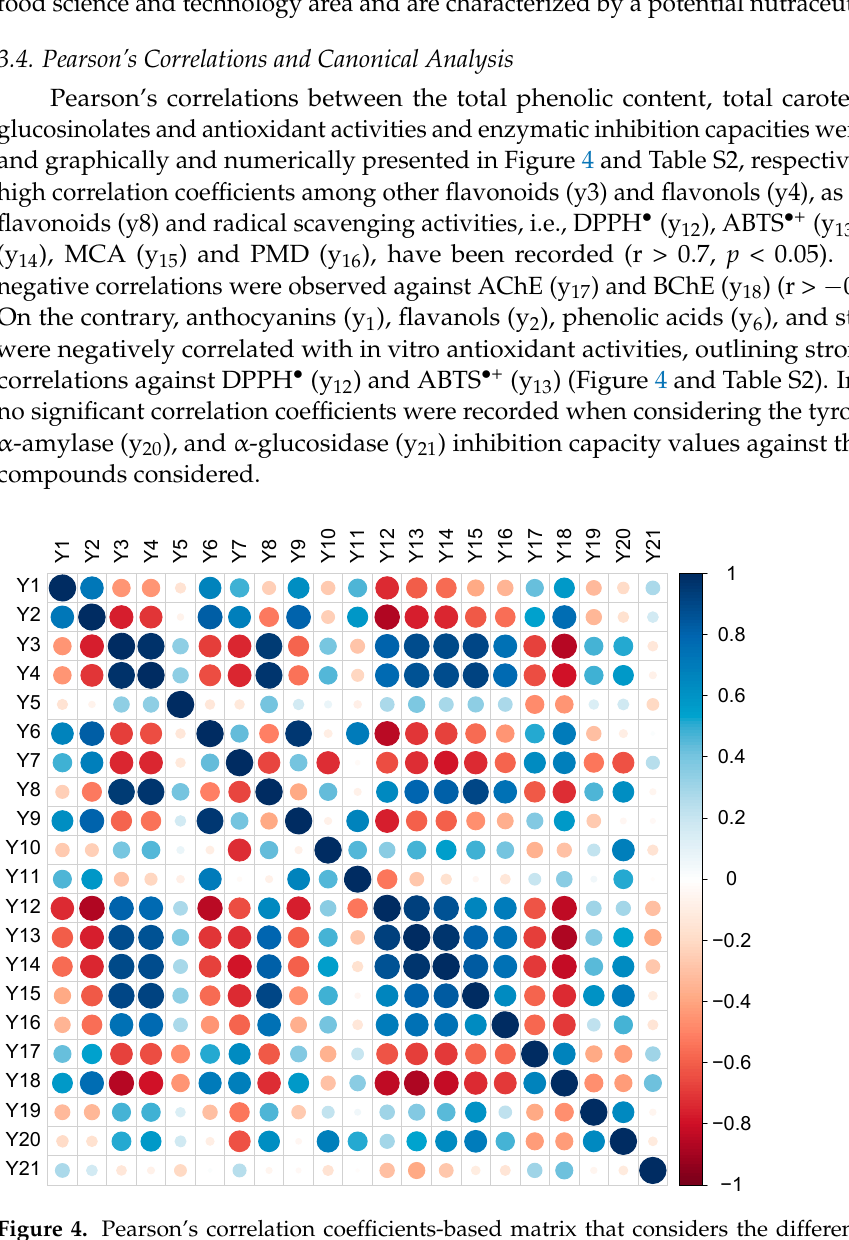
Figure 4. Pearson’s correlation coefficients-based matrix that considers the different dependent variables measured. Blue dots: positive correlations; red dots: negative correlations. Anthocyanins (y 1 ), flavanols (y 2 ), other flavonoids (y 3 ), flavonols (y 4 ), low-molecular-weight (LMW) phenolics (y 5 ), phenolic acids (y 6 ), stilbenes (y 7 ), total flavonoids (y 8 ), total phenolics (y 9 ), total carotenoids (y 10 ), total glucosinolates (y 11 ), DPPH • (y 12 ), ABTS •+ (y 13 ), CUPRAC (y 14 ), MCA (y 15 ), PMD (y 16 ), AChE (y 17 ), BChE (y 18 ), tyrosinase (y 19 ), α -amylase (y 20 ), and α -glucosidase (y 21 ).